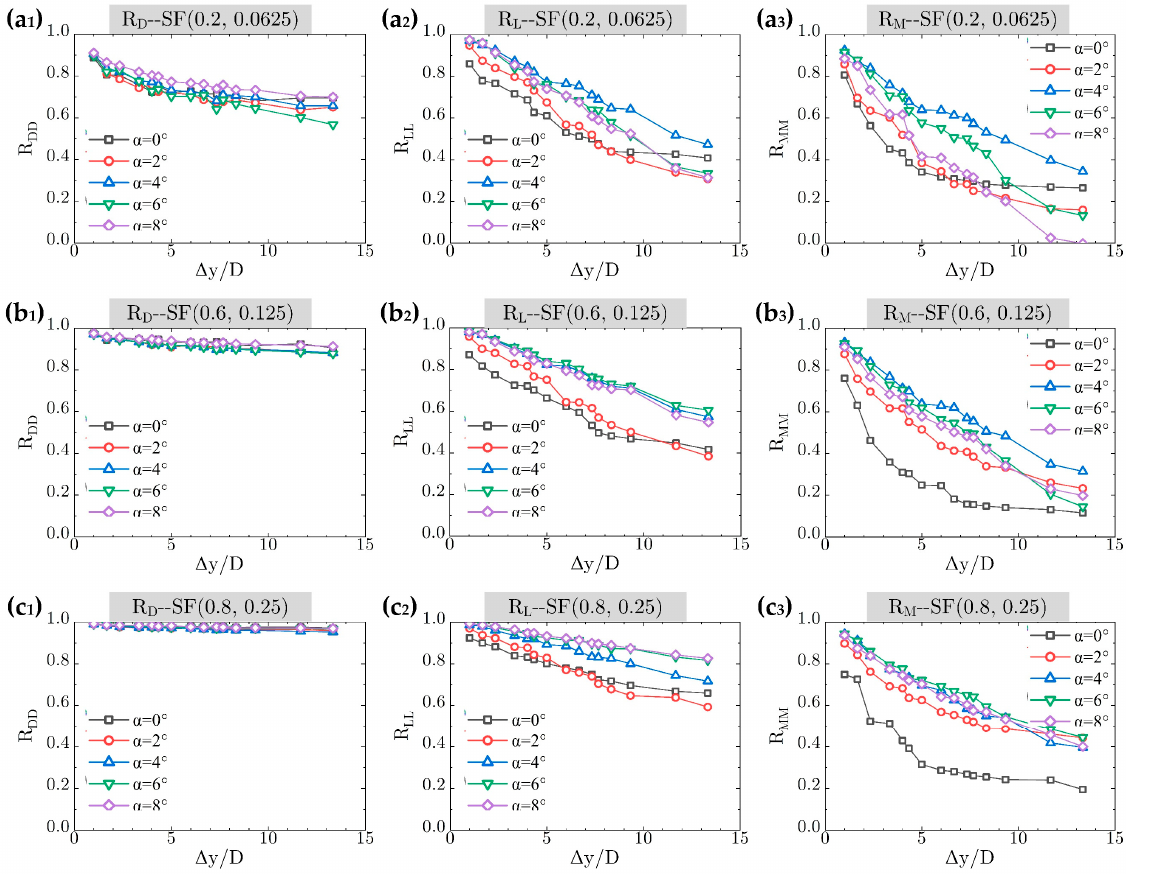
Figure 12. Spanwise correlation coefficients of drag, lift, and pitching moment in typical sinusoidal flows. Top row: SF (0.2, 0.0625); Middle row: SF (0.6, 0.125); Bottom row: SF (0.8, 0.25).